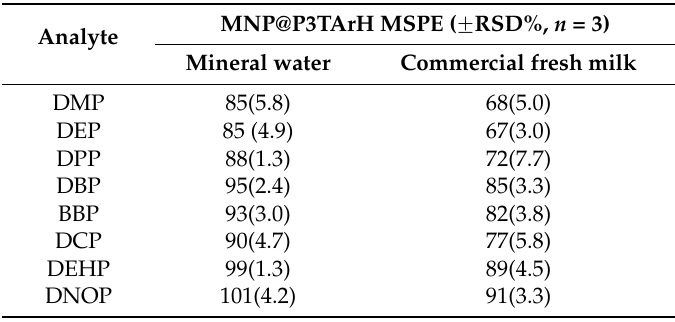
Figure 10. Chromatogram of commercial fresh milk: ( a ) unspiked; ( b ) spiked phthalates (50 µg·L − 1 ). Peaks: (1) DMP; (2) DEP; (3) DPP; (4) DBP; (5) BBP; (6) DCP; (7) DEHP; (8) DNOP. Table 4. Analysis of analytes in the real